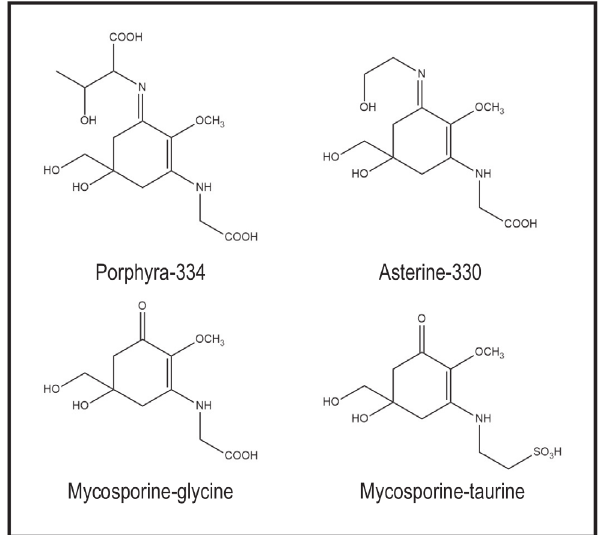
FIGURE 3 - Molecular structure of some common mycosporin like amino acids found in